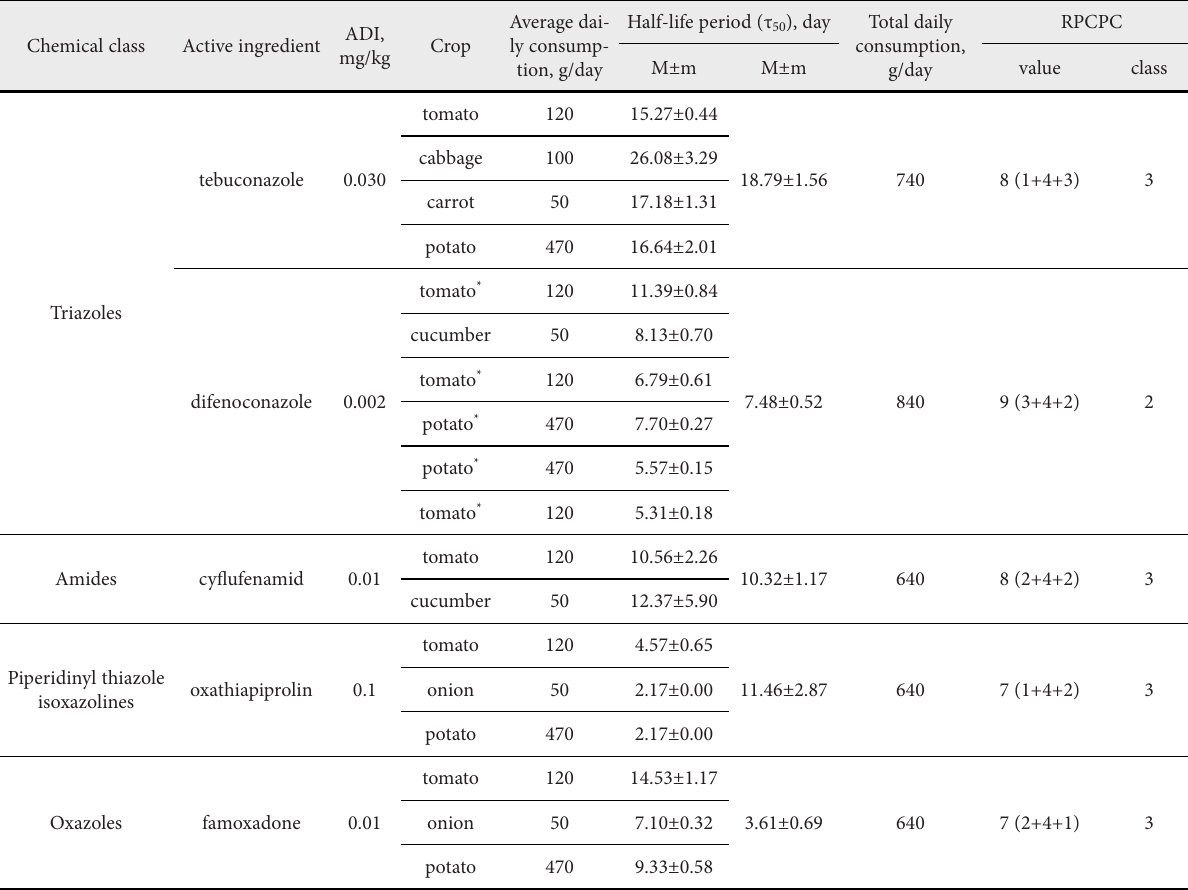
Assessment of the risk of adverse effects of fungicides on human health when consuming vegetable products grown in their